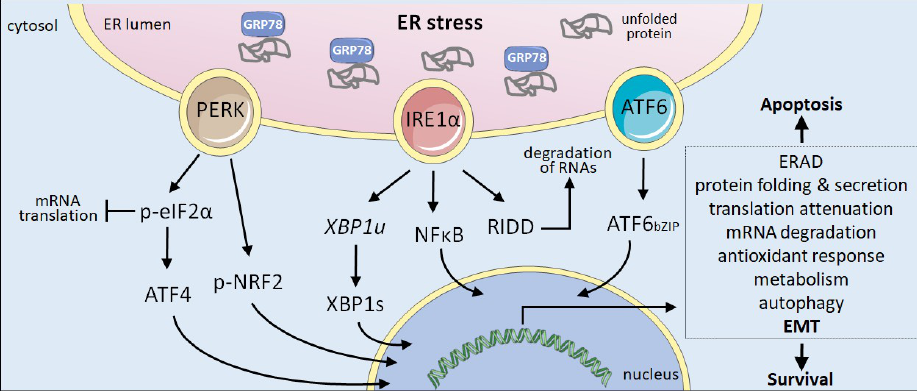
Figure 1. The UPR. The ER protein maturation capacity may be overwhelmed due to the action of several cell intrinsic and extrinsic factors, causing ER stress. The accumulation of unfolded proteins triggers the activation of the three ER-resident sensors responsible for UPR by sequestering GRP78. IRE1 mediates the unconventional splicing of the mRNA encoding XBP1 (XBP1u) rendering the functional transcription factor XBP1s and can activate NFκB signalling. IRE1 RNase degrades ER associated RNAs through RIDD (regulated IRE1-dependent decay). PERK phosphorylates eIF2α to